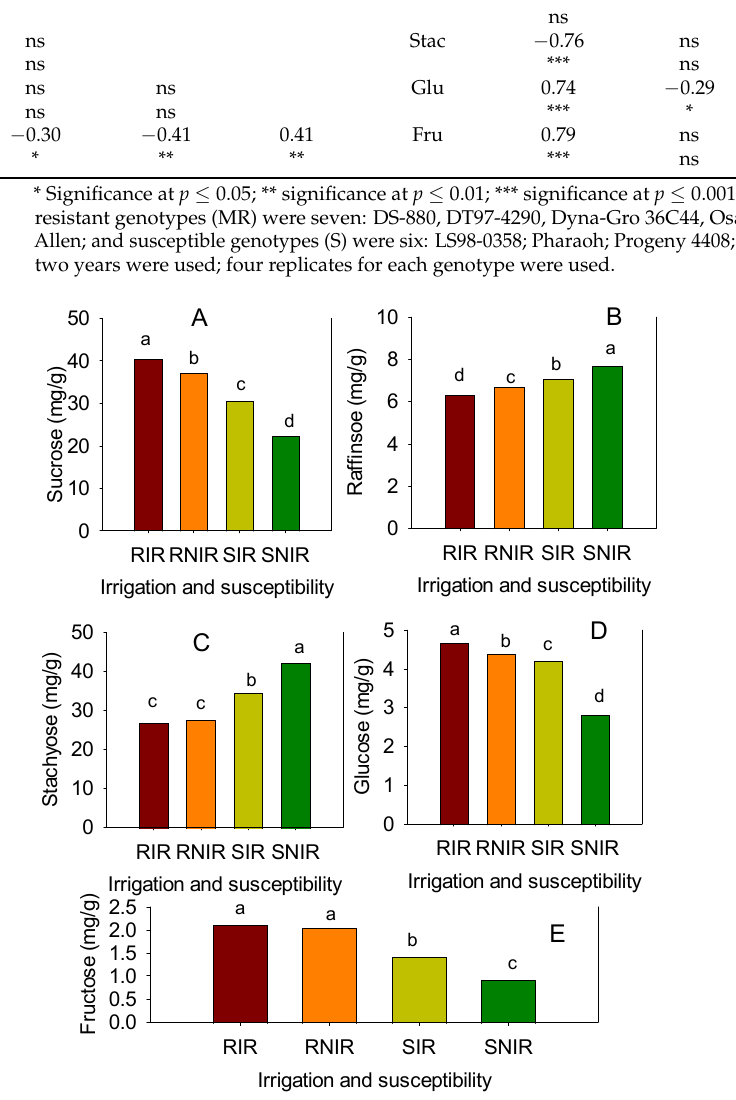
Figure 2. Soybean seed sucrose, ( A ); raffinose, ( B ); stachyose, ( C ); glucose, ( D ); and fructose, ( E ) across two years in moderately resistant (R) and susceptible (S) soybean genotypes under irrigated (IR) and non-irrigated (NIR). Moderately resistant genotypes (R) were seven: DS-880, DT97-4290, Dyna-Gro 36C44, Osage, R07-7232, USG 75Z38, USG Allen; and susceptible genotypes (S) were six: